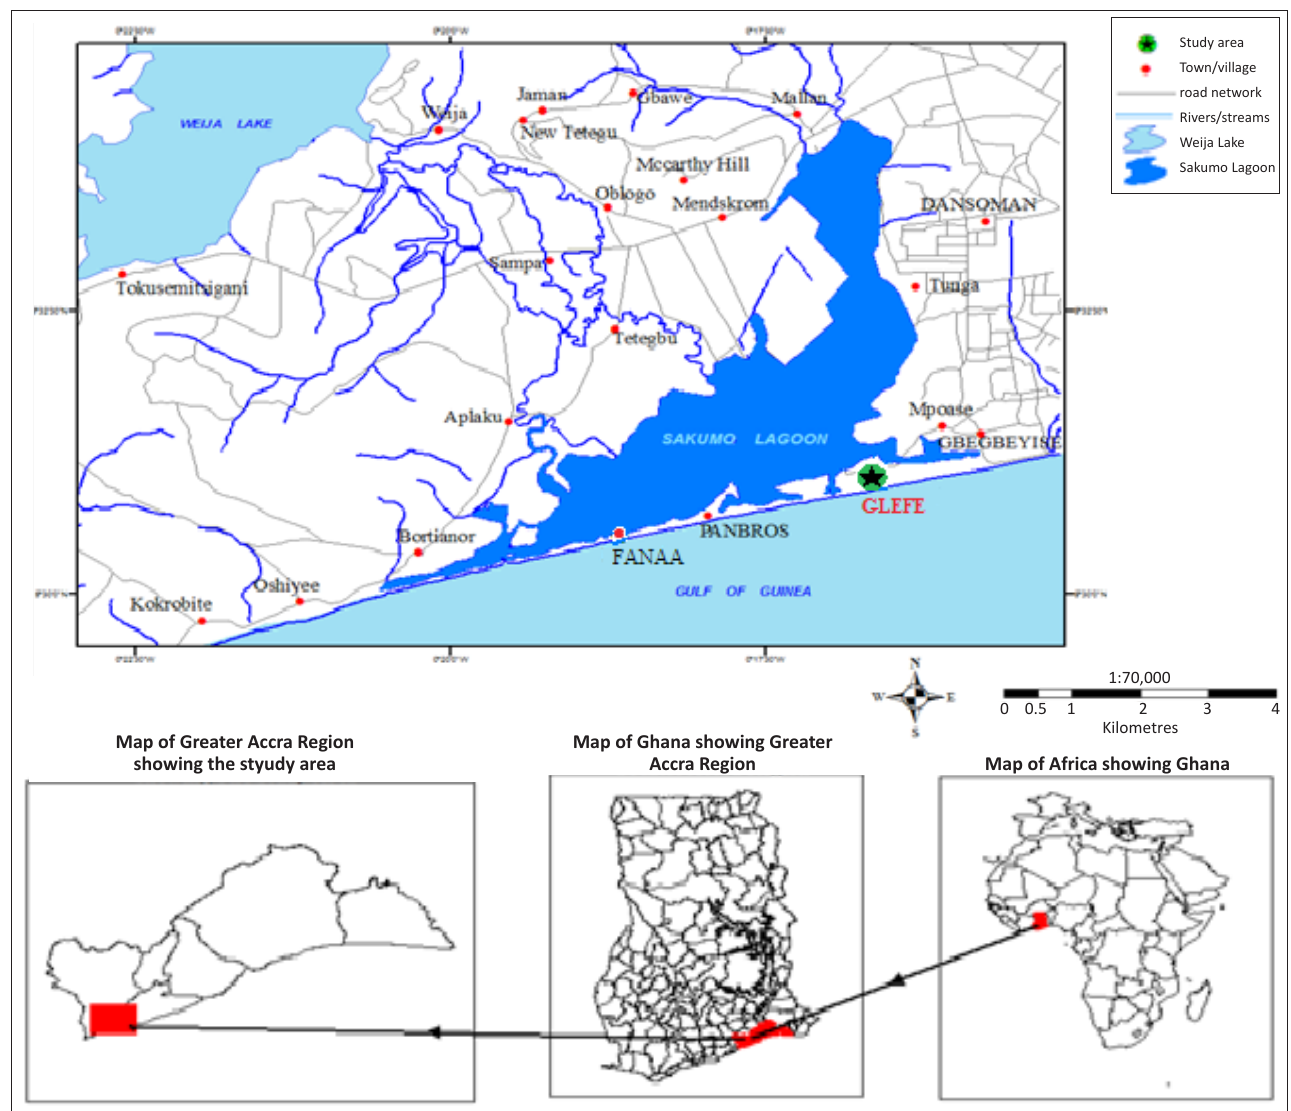
FIGURE 1: The study area (Glefe) located in the Densu wetland